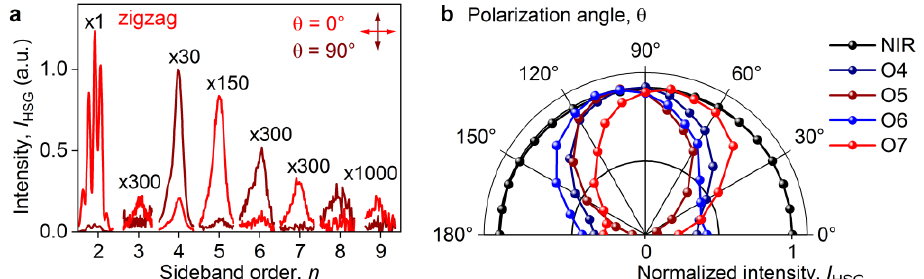
Fig. 2. a High-order sideband intensity I HSG (multiplied with indicated factors) in the polarization basis parallel (  = 0°, light colors) and perpendicular (  = 0°, dark colors) to the driving field. Even and odd orders are cross-polarized. b For a selective excitation at the K valley with a circularly- polarized preparation pulse (black curve), the intense multi-THz fields drive electron – hole pairs into the non- excited K’ valley adding polarization components of opposite helicity which causes the emission of elliptically polarized sidebands (normalized, colored data